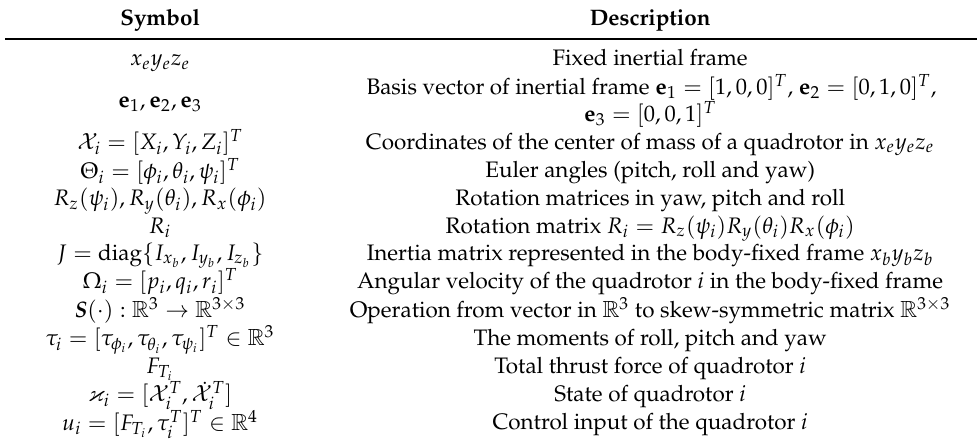
Table 1. The denotations of the variables in the dynamic model of